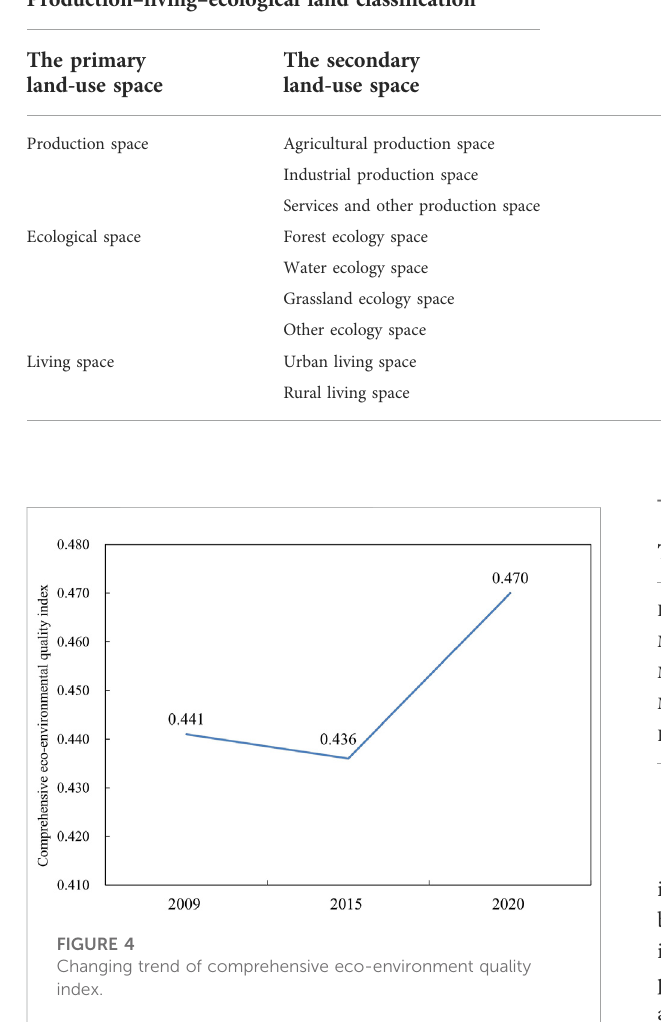
TABLE 4 Eco-environment quality index.